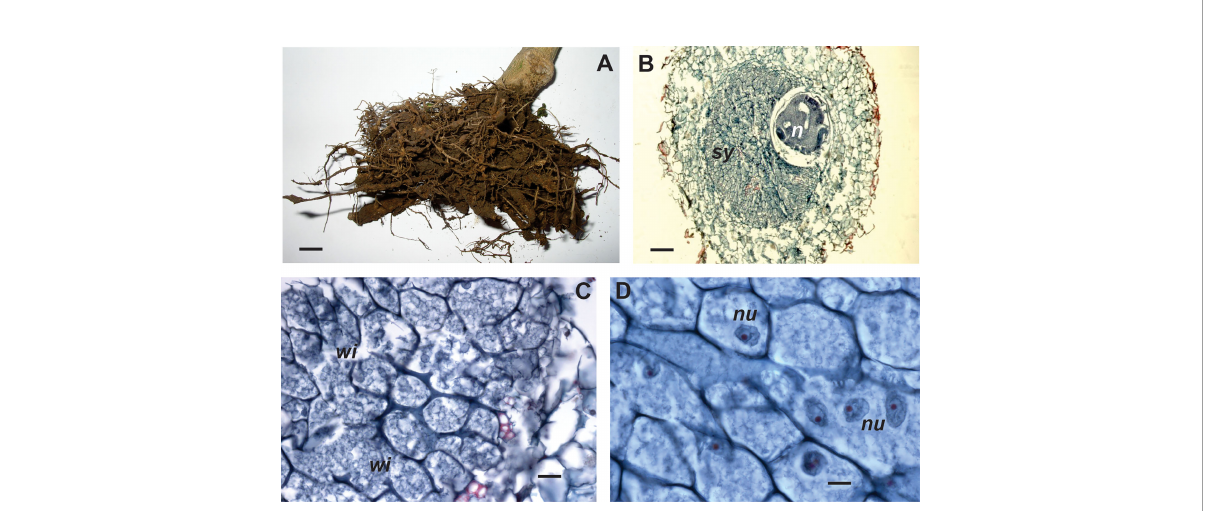
FIGURE 3 External view and anatomy of galls induced by Nacobbus celatus in different pepper cultivars. (A) Cv. Yatasto with poor root development due to severe nematode attack and some galls. Histological cross-sections of gall. (B) Cv. California wonder, syncytium ( sy ) located in the central cylinder and body female ( n ); (C) Cv. Yatasto, detail of syncytial cells with dense cytoplasm, thickened walls and few wall interruptions (wi); (D) Cv. Fyuco, detail of syncytial cells with several nuclei ( nu ) of different shape and size. Scale bars: A = 5 mm; B = 100 m m; C = 20 m m; D = 10 m